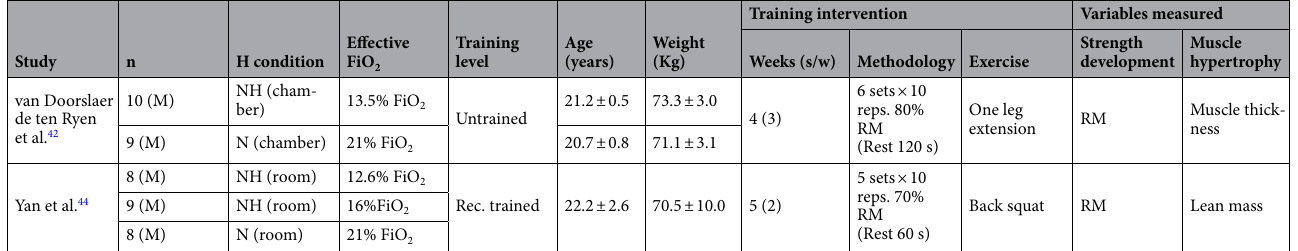
Table 1. Main characteristics of included studies in the meta-analysis. n: sample size; H: hypoxia; N: normoxia; NH: normobaric hypoxia; FiO 2 : fraction of inspired oxygen; SpO 2 : arterial oxygen saturation; s/w: sessions per week; reps.: repetitions; Bt: between; Rec.: recreationally; RM: repetition maximum; CSA: cross- sectional area; M: male; F: